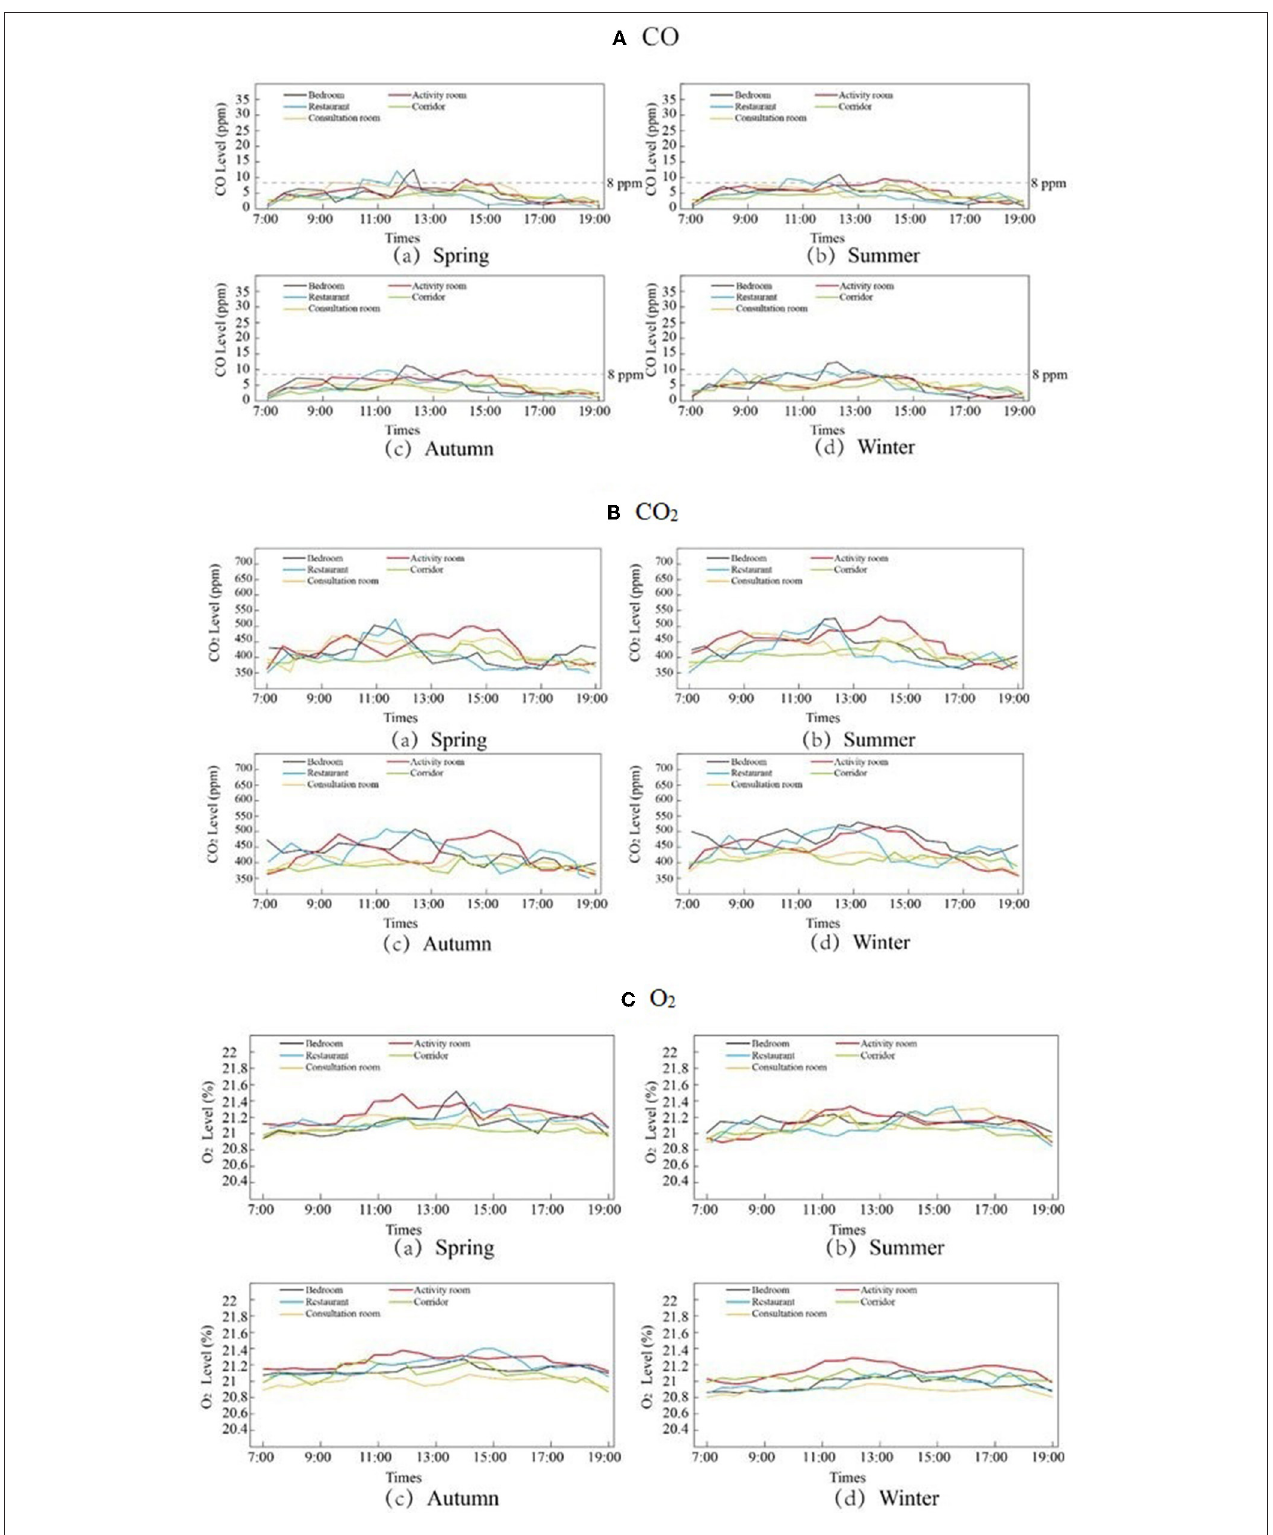
FIGURE 11 | CO CO 2 and O 2 measurement in different seasons and different rooms. (A) CO, (B) CO 2 , and (C) O 2 .